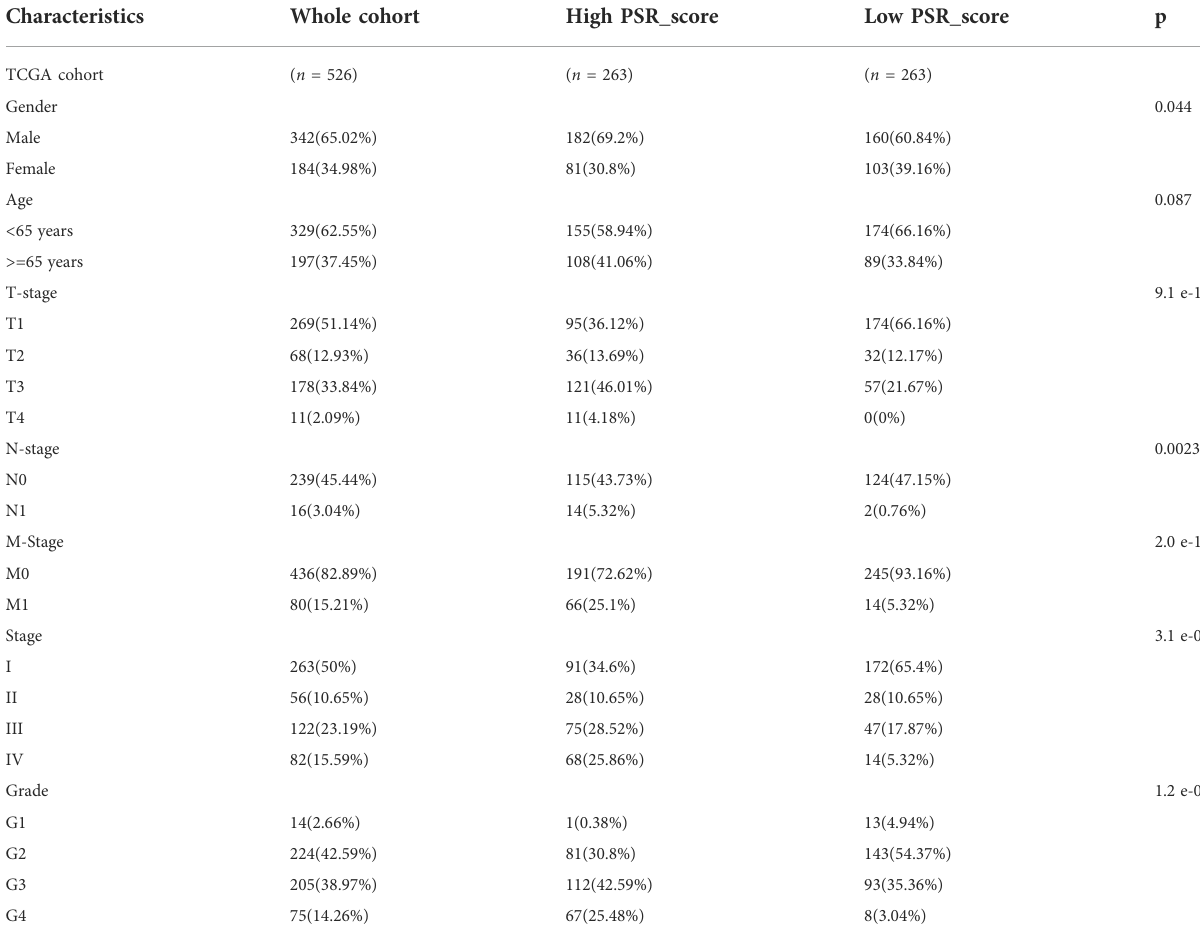
TABLE 1 Baseline characteristics of patients in TCGA KIRC cohort